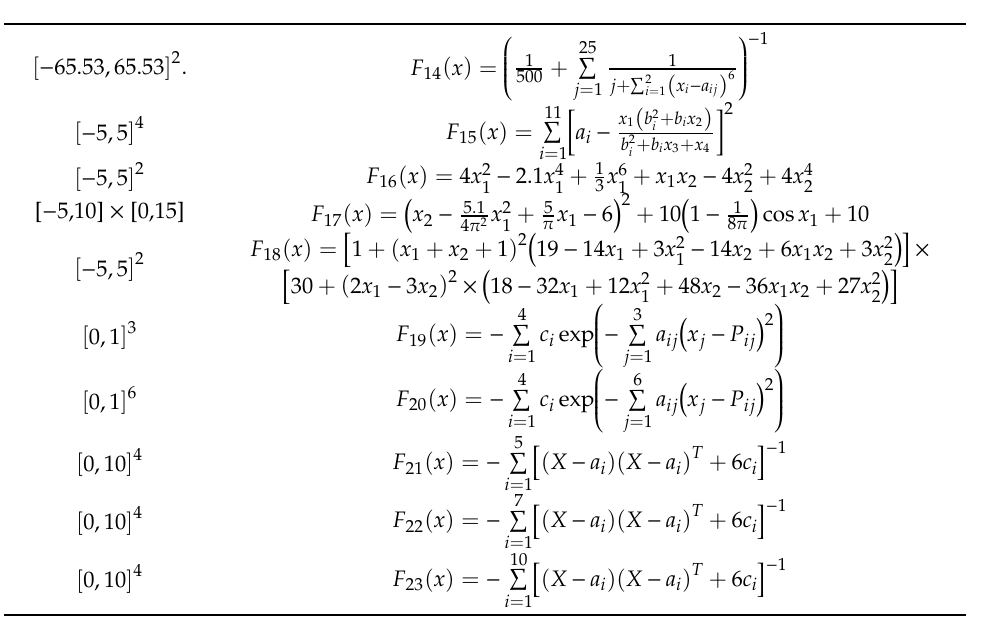
Table A10. Multimodal test functions with fixed